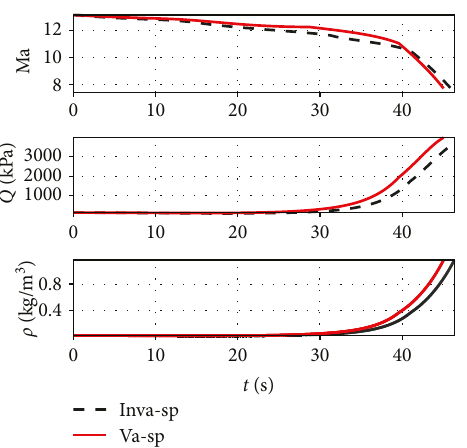
Figure 11: Curves representing the Mach number, dynamic pressure, and air density. Inva_sp: invariable span; Va-sp: variable